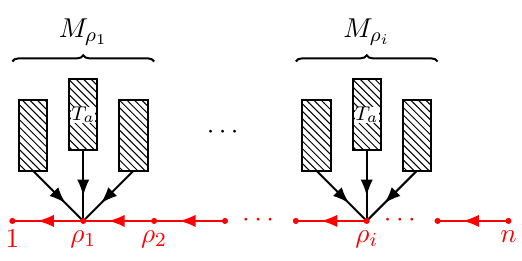
Figure 3 . A typical spanning tree with the baseline shown in red, where T a ∈ M ρ merging at ρ i on the baseline.